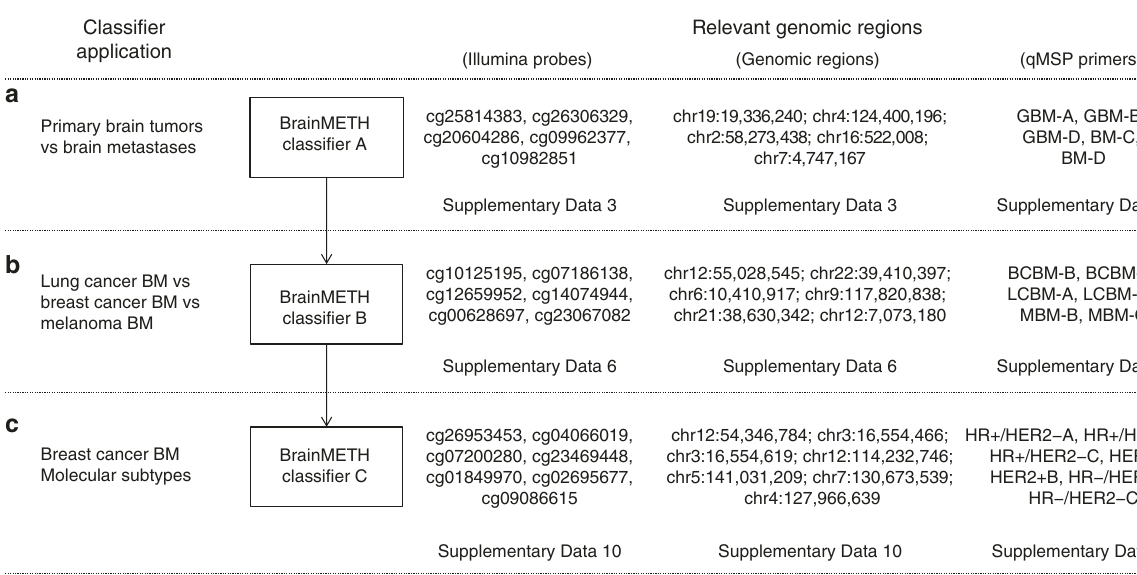
Fig. 6 Summary of the BrainMETH classi fi ers. a – c BrainMETH classi fi ers designed to discriminate between primary and metastatic brain tumors (Classi fi er A), among BM from different tumor of origin (Classi fi er B), and among BCBM from different molecular subtypes (Classi fi er C). A set of relevant Illumina probes, genomic regions, and validated primer sets by qMSP is provided for each step of the BrainMETH classi fi